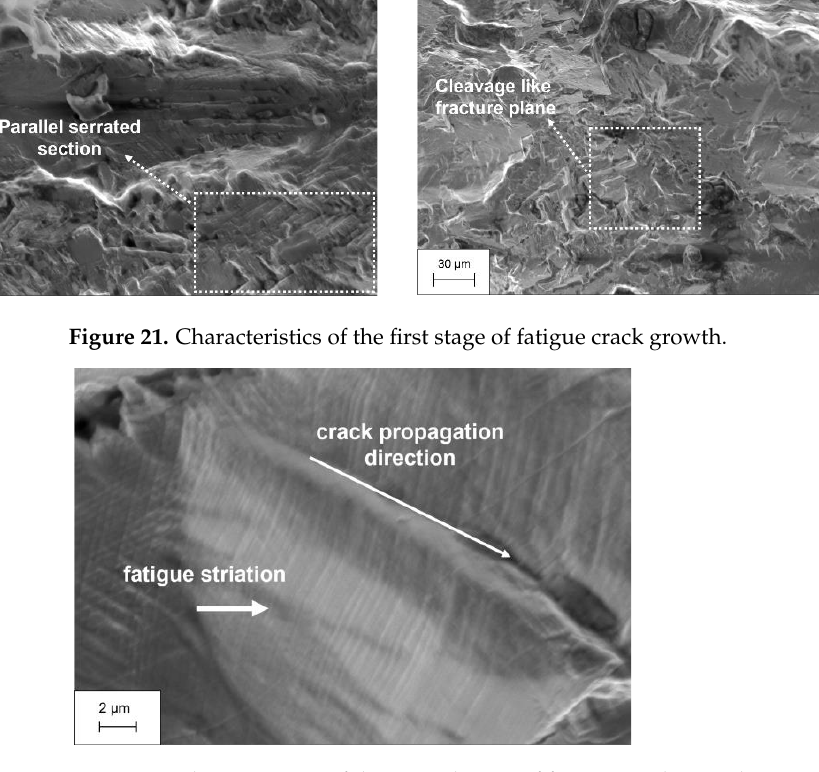
Figure 22. Characteristics of the second stage of fatigue crack growth.